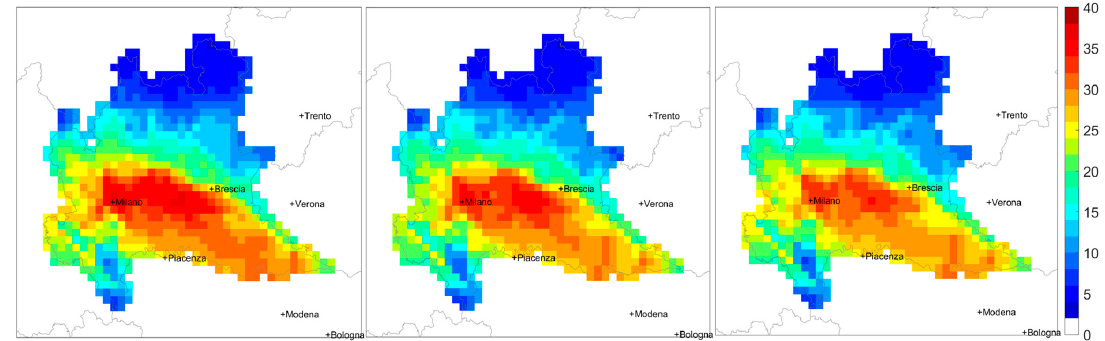
Figure 8. PM10 yearly concentration in the CLE2020 scenario (on le the left), PBP (in the center), and the optimal policy (on the right) ( μ g/m 3 ).